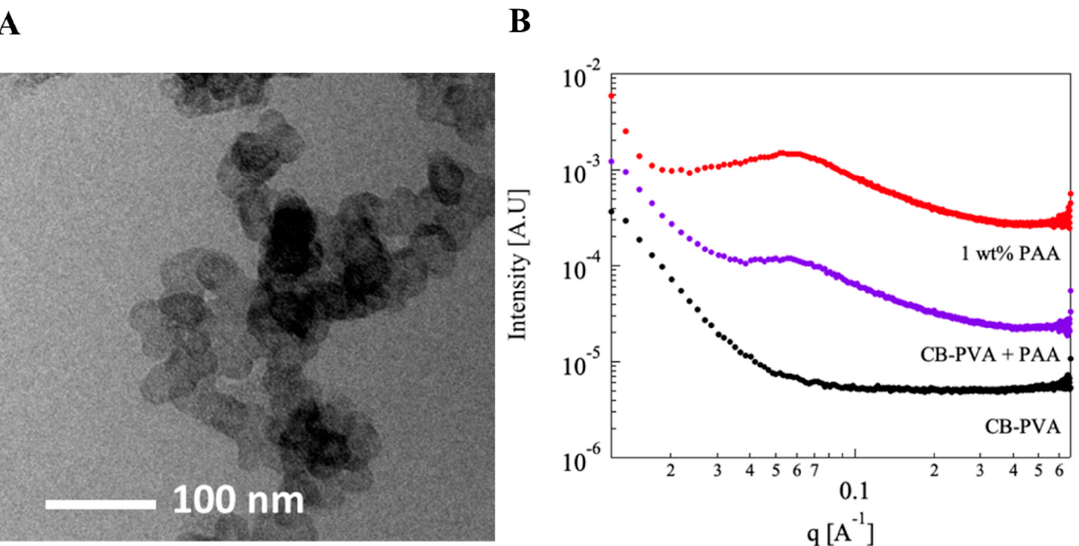
Figure 6. ( A ) Cryo-TEM image of a dispersion of 1 wt% CB -PVA at pH = 7 (see also an image of the dispersion at pH = 4, in Figure S4 of the ESI). ( B ) Raw 1D SAXS measurements of 1 wt% PAA ( ● ) 0.2 wt% CB-PVA dispersion ( ● ) and solvated 1 wt% PAA in 0.2 wt% CB-PVA dispersion ( ● ), all at pH = 7. The curves are shifted for better visualization.